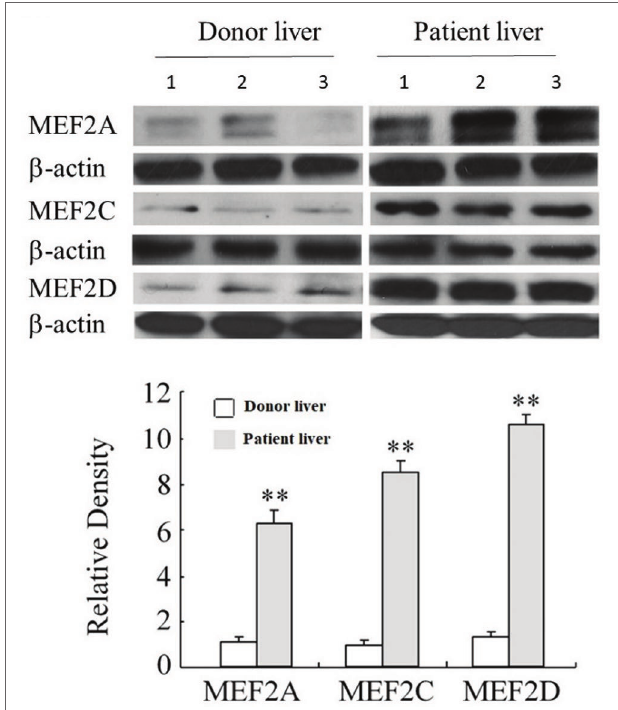
FIGURE 2 | Expression of MEF2 in normal and cirrhotic human livers. The levels of MEF2A, MEF2C, and MEF2D proteins were determined by western blot. Numbers 1 to 3 indicate the samples from individual human. The bottom panel shows densitometry values of MEF2 proteins relative to β -actin. Each value represents the mean ± SEM ( n = 3, ** p < 0.01 vs.